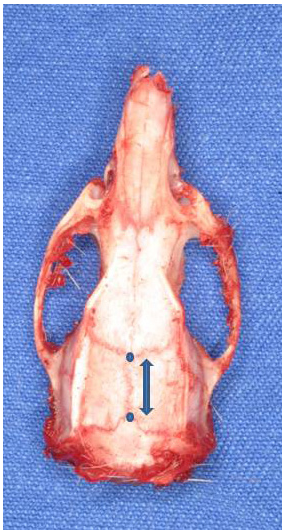
FIGURE 3 - The superior view of dissected craniofacial skeleton of adult age rats that had undergone fetal constraint. Note the landmarks for morphologic measurements of the sagittal suture